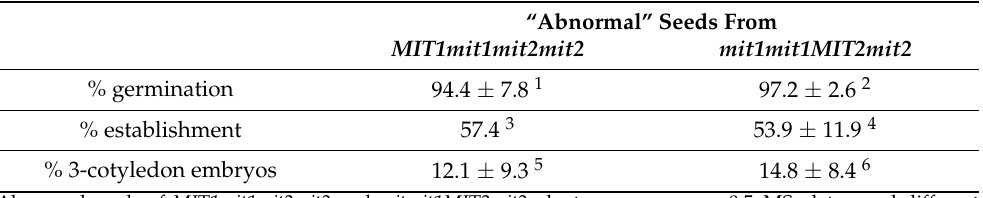
Table 2. Characterization of “abnormal” seeds obtained from plants with three mutated mit alleles.